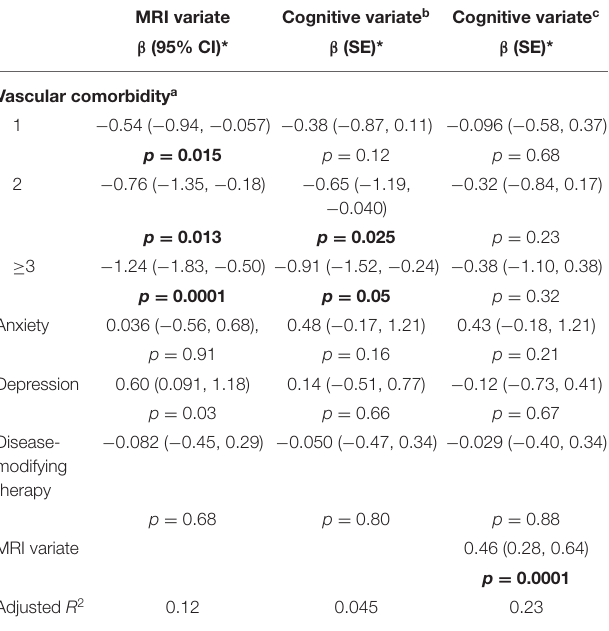
TABLE 2 | Association of comorbidity with cognitive variate and magnetic resonance imaging (MRI) variate. MRI variate Cognitive variate b Cognitive variate c